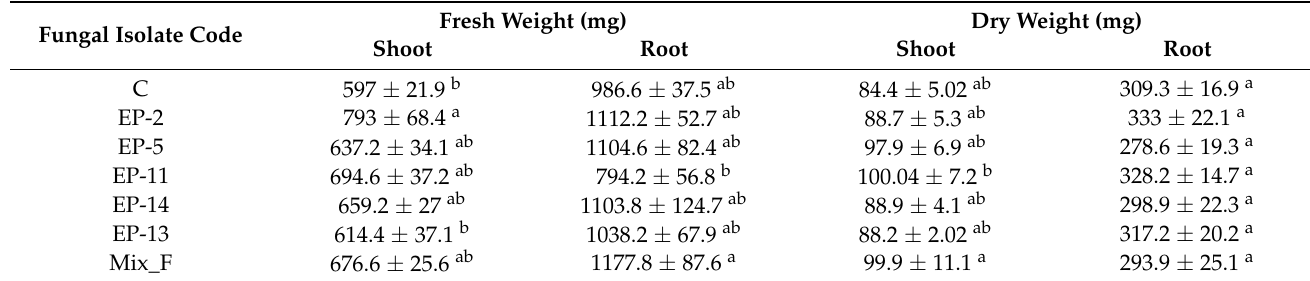
Table 5. Effect of fungal inoculation on root and shoot of the Zea mays L.